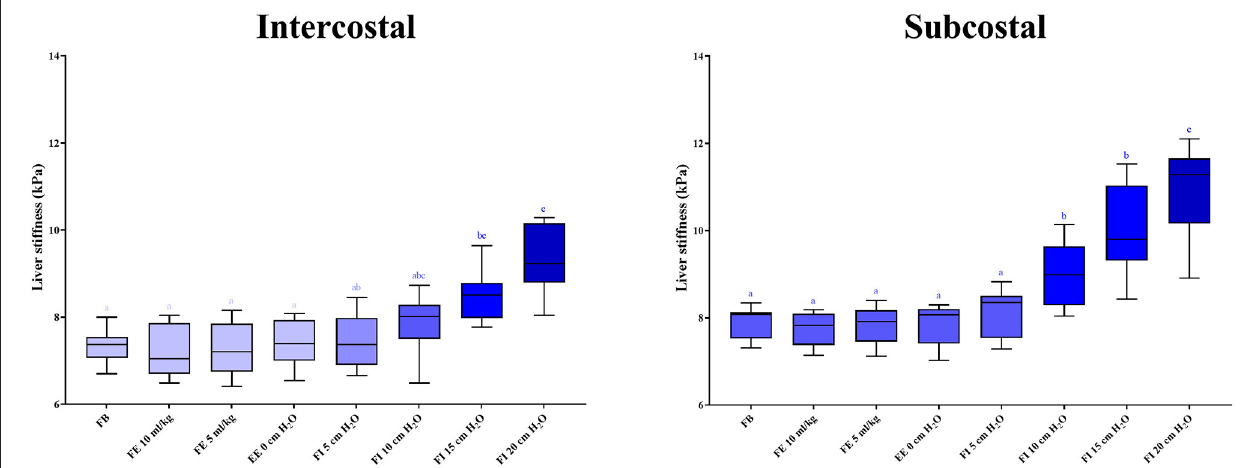
FIGURE 5 | Box plots representing liver stiffness according to breathing phases. Boxes not sharing the same letters exhibit significant differences in liver stiffness ( p < 0.05). Liver stiffness is significantly higher in forced-inspiration 15 and 20cm H 2 O than in the other breathing phases in the intercostal approach. Liver stiffness is significantly higher in forced-inspiration 10, 15, and 20cm H 2 O than in the other breathing phases in the subcostal approach. FB, free-breathing; FE, forced-expiration; EE, end-expiration; FI, forced-inspiration.